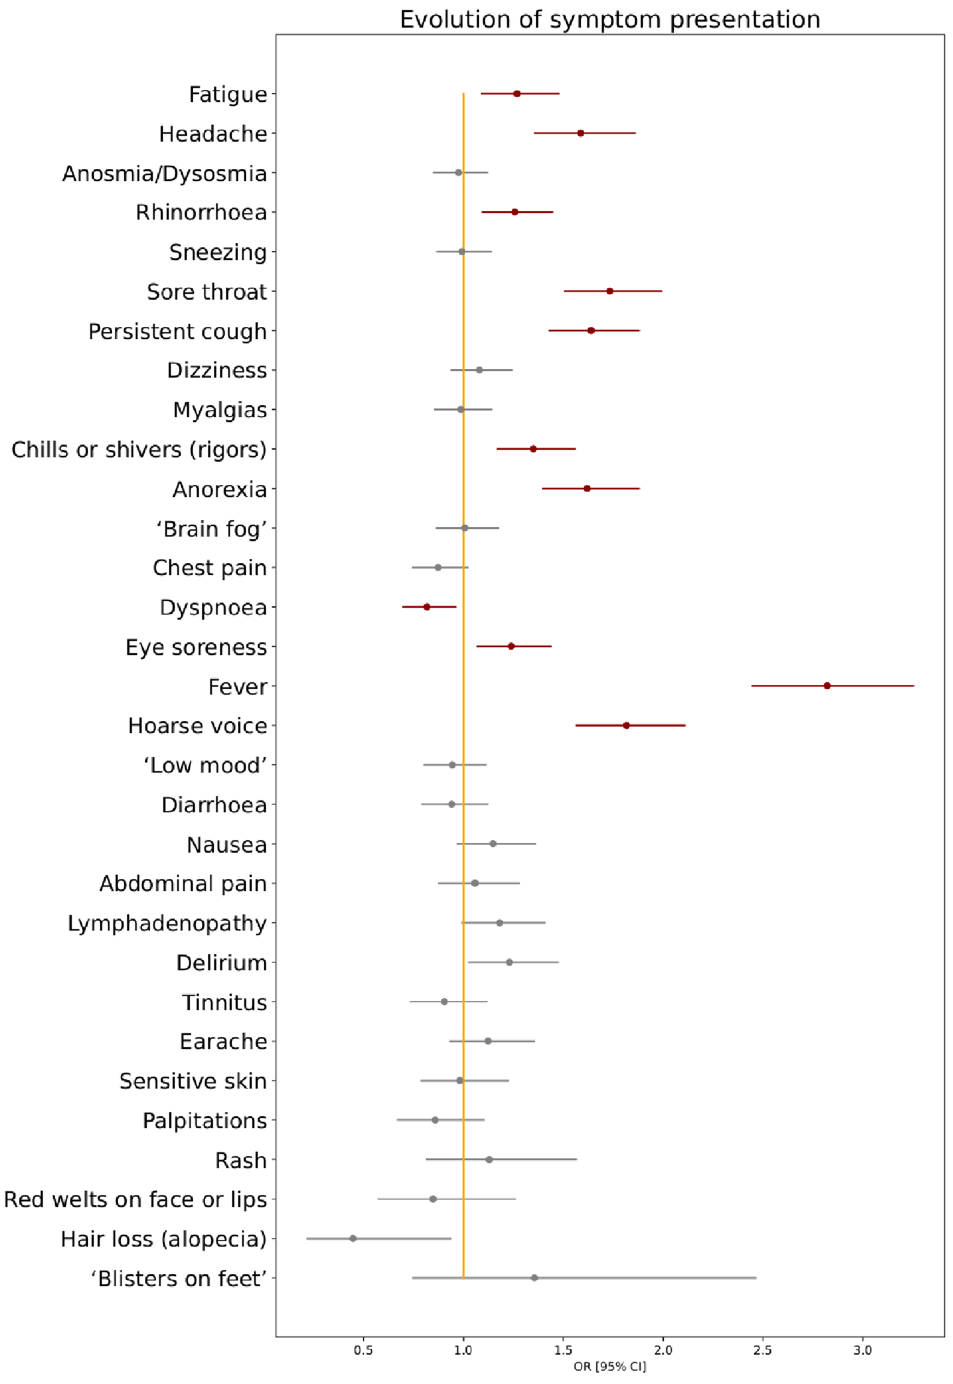
Figure 2. Odds ratios for any symptom presenting within the first 28 days of illness in individuals with COVID-19 during periods of SARS-CoV-2 Delta versus Alpha variant predominance. Age, gender, and vaccination.status are included as covariates in this analysis. Red markers encode statistical significance with α-value < 0.05, whereas grey markers encode non-significant differences, after correction for false discovery